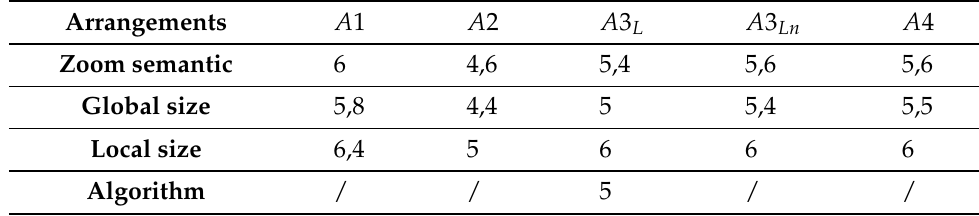
Table 4. User evaluation (/10) of overlap-removal options.